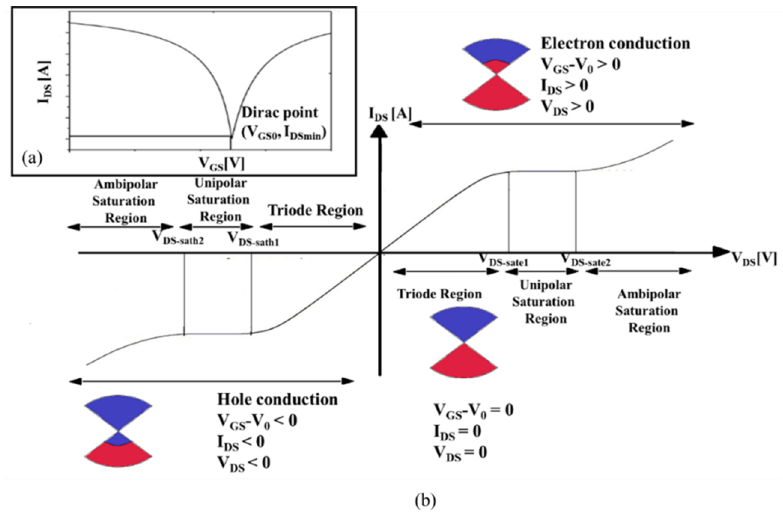
Figure 6. Graphene transistor characteristic curves: ( a ) I DS -V GS characteristics when V DS is constant; ( b ) I DS -V DS characteristics.